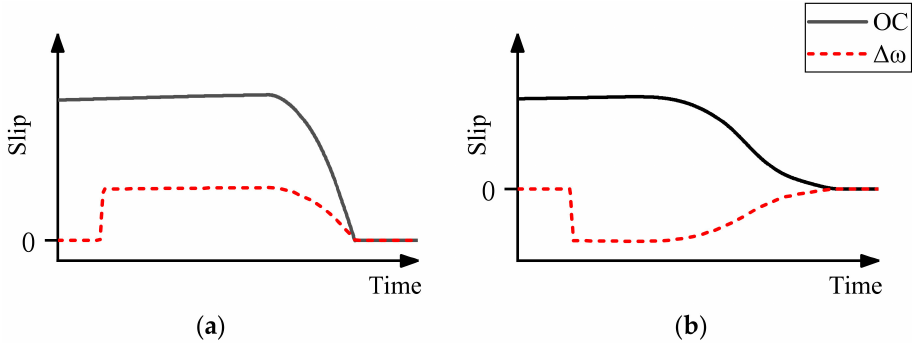
Figure 4. Comparison between the ∆ ω and OC clutch slip. ( a ) Upshift; ( b ) downshift.